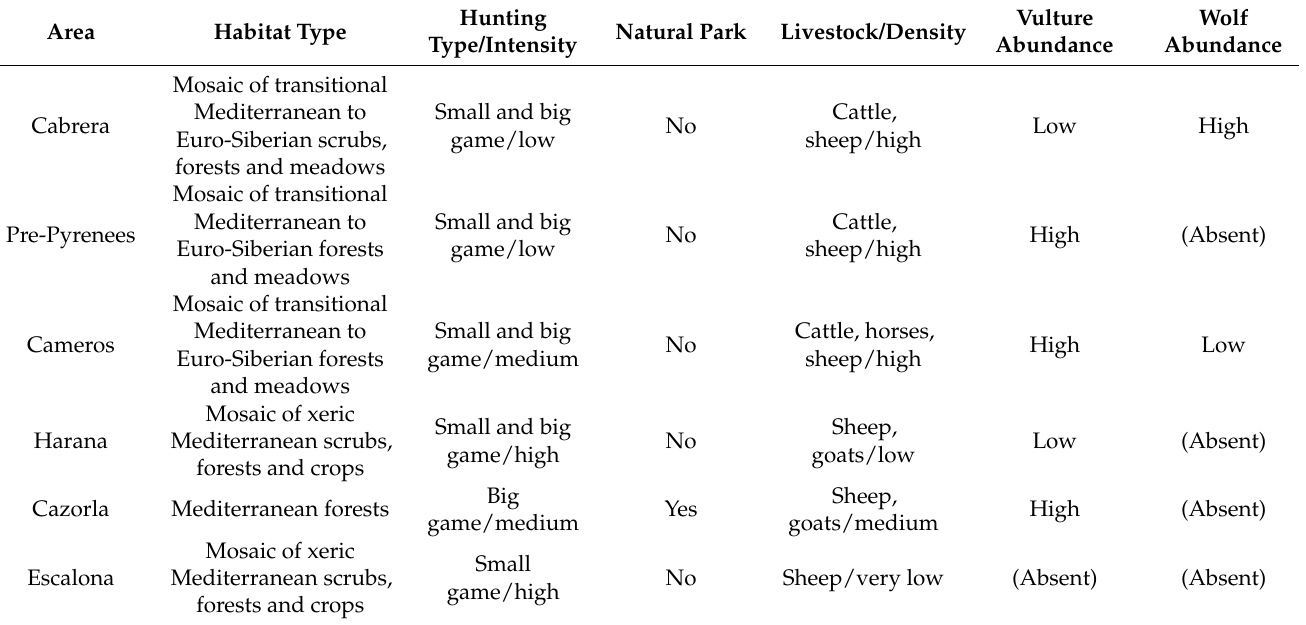
Table 1. Description of the six study